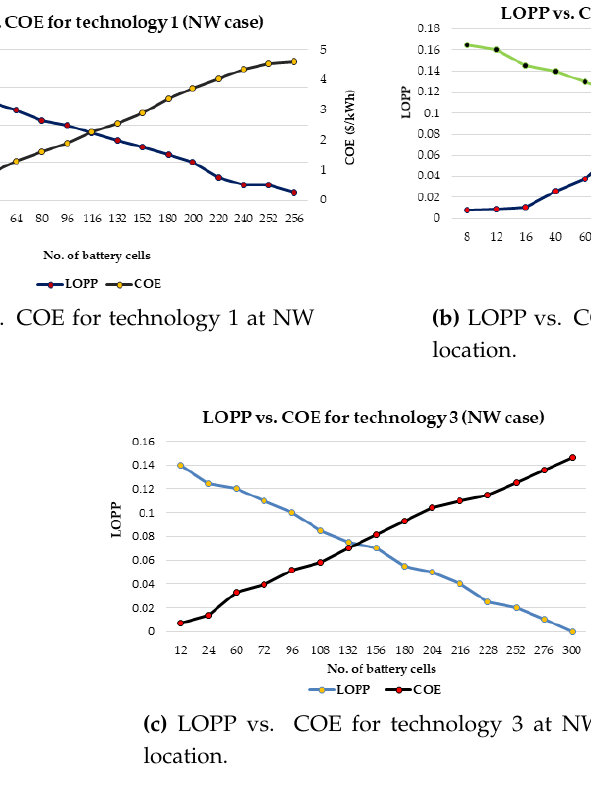
Figure 13. Technology selection for NW